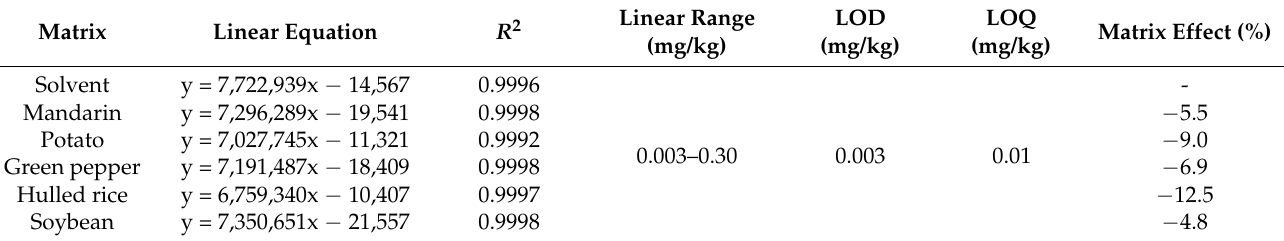
Table 2. A comparison of matrix-matched calibration and solvent calibration.